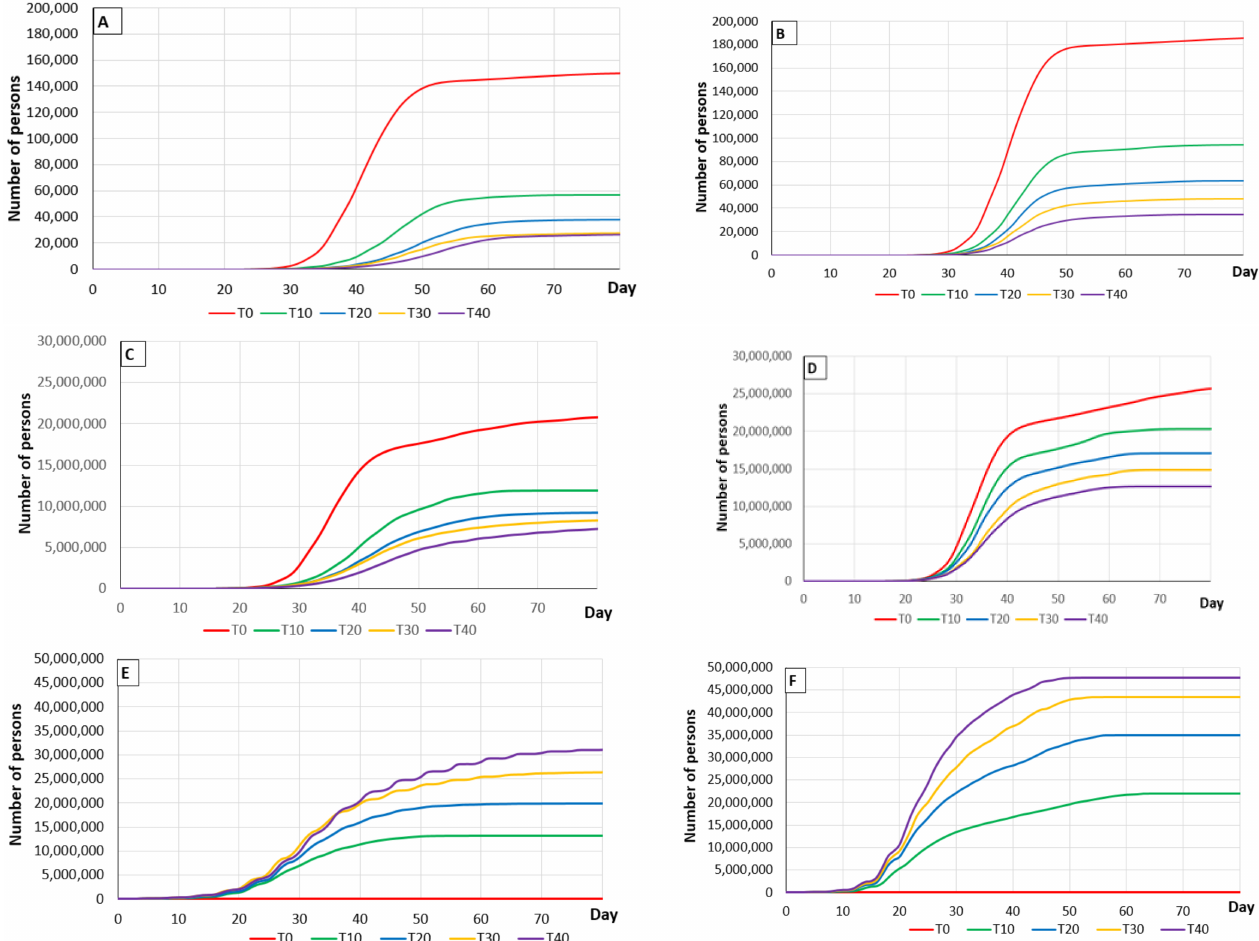
Figure 2. Graphs ( A , B ) show the progress of the death toll in Spain depending on the percentage of contacts traced (from 0% (T0) to 40% (T40)) with and without the application of social measures, respectively using a PDP model over an 80-day period. Graphs ( C , D ) show the number of people recovering depending on tracing contacts (from 0% (T0) to 40% (T40)) with and without the application of social measures, using a PDP model over an 80-day period. Graphs ( E , F ) show the number of diagnostic tests carried out depending on tracing contacts (from 0% (T0) to 40% (T40)) with and without the application of social measures, using a PDP model over an 80-day